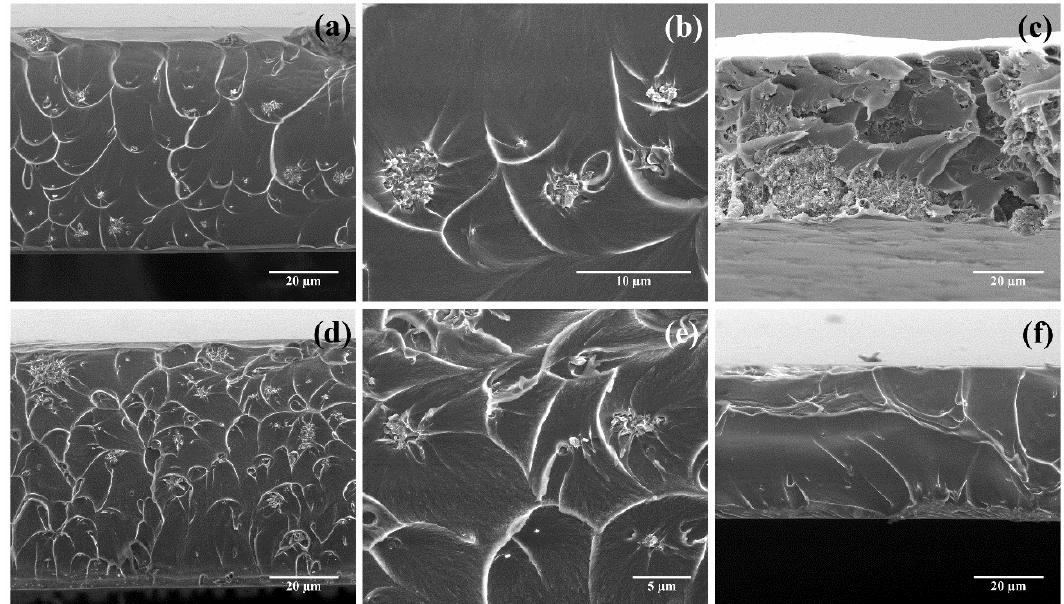
Figure 4. Cross-sectional SEM micrographs for MMMs doped with g-C 3 N 4 subjected to different treatments and prepared with different sonication times: Matrimid membrane doped with 0.5 wt % protonated g-C 3 N 4 at 3000 × ( a ) and 6000 × ( b ) magnification; Matrimid membrane doped with 10 wt % protonated g-C 3 N 4 loading after 4 hours of sonication ( c ) at 3000 × ; Matrimid loaded with 0.5 wt % g-C 3 N 4 treated with oxygen plasma at 3000 × ( d ) and 10000 × ( e ); Matrimid loaded with 0.5 wt % hydrazine monohydrate-treated g-C 3 N 4 at 3000 × ( f ). Micrographs of MMMs at 2 wt % loading were analogous to the ones at 0.5 wt %.